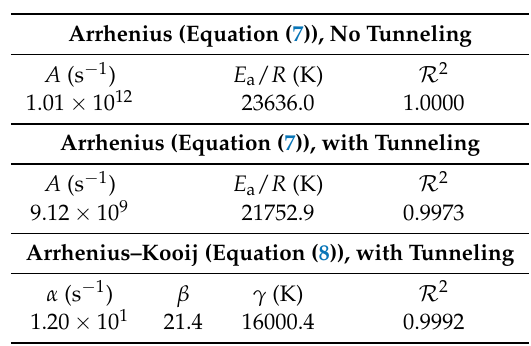
Figure 5. Arrhenius plot of the computed thermal rate coefficient (both neglecting and including tunneling) for the isomerization reaction of hydroxyacetone to 2-hydroxypropanal (Figure 3) and of the Arrhenius and Arrhenius–Kooij best-fitting curves. Table 1. Results of the fit of the Arrhenius and Arrhenius–Kooij equations to the computed thermal rate coefficients for the isomerization reaction of hydroxyacetone to 2-hydroxypropanal in the temperature range 151–501